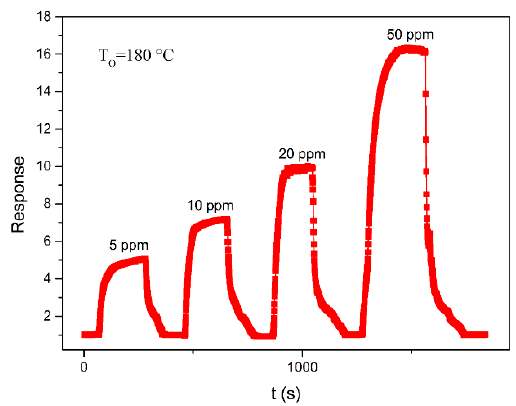
Figure 5. ( a ) TEM image of the SnO 2 ; ( b ) HRTEM image of as-obtained SnO 2 particles; ( c ) The selected area diffraction pattern of SnO 2 particle.